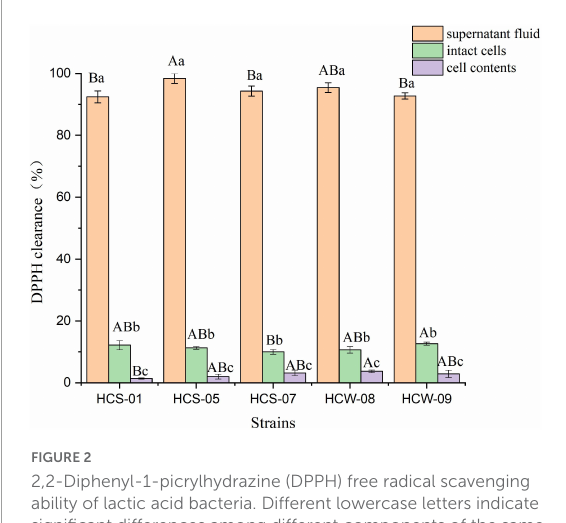
FIGURE3 Hydroxyl radical scavenging ability of lactic acid bacteria. Different lowercase letters indicate significant differences among different components of the same strain ( P < 0.05); different capital letters indicate significant differences among the same components of different strains ( P <